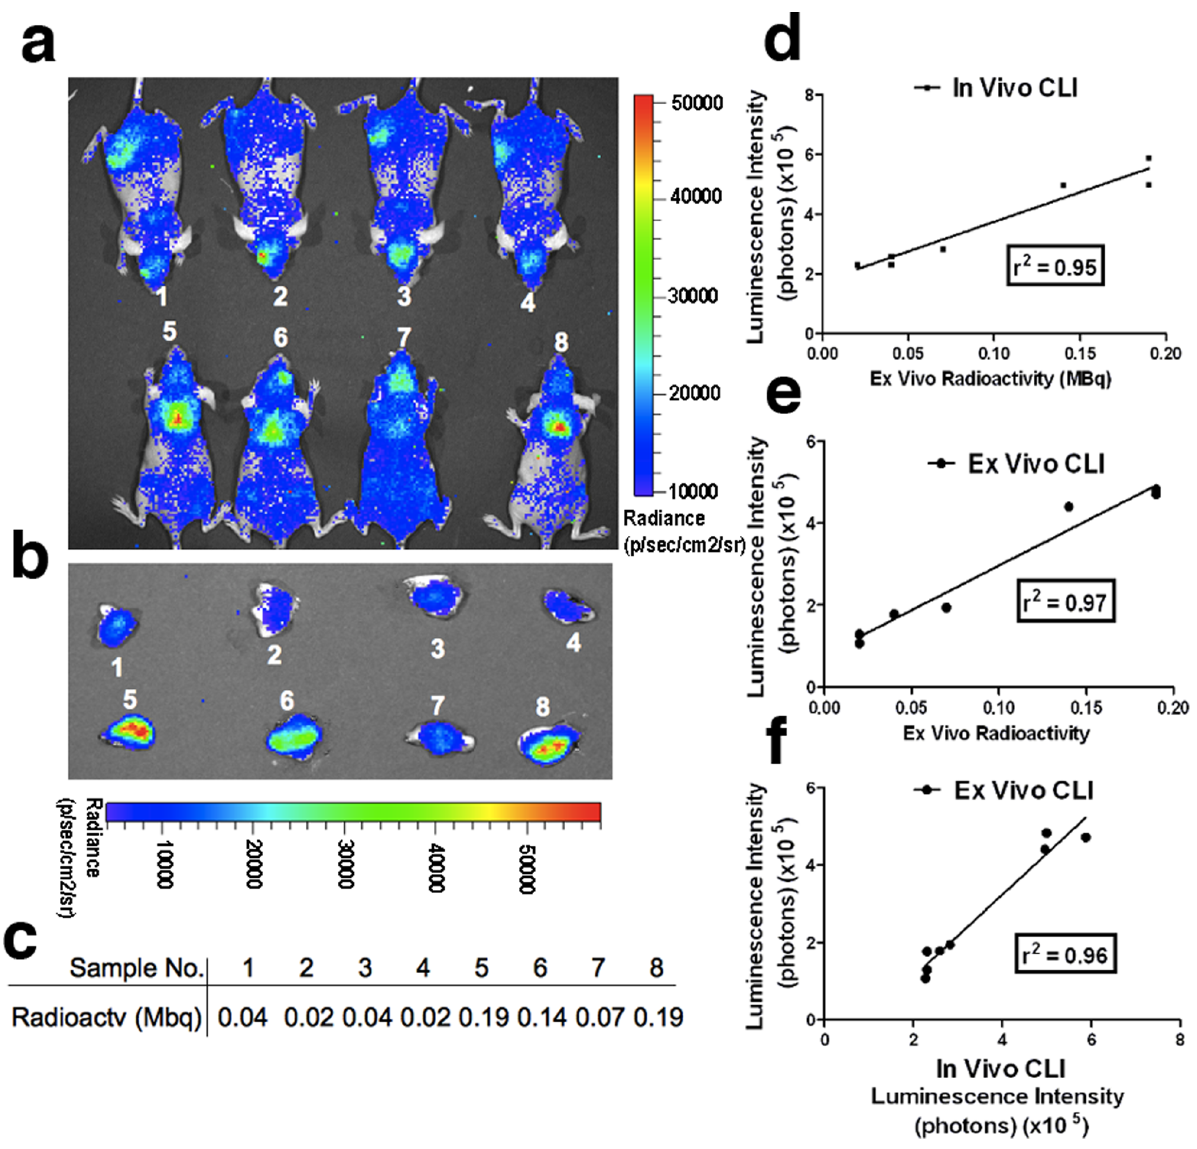
Figure 3. Reliability correlation studies of invivo CLI imaging, exvivo CLI imaging, and radioactive dosimetric countings of BAT. (a) In vivo CLI images of mice injected with 18 F-FDG under ketamine/xylazine anesthesia without (top panel, mice # 1–4) and with NE treatment (lower panel, mice # 5–8). (b) Ex vivo CLI images of BAT of mice in (a). (c) Dosimetric countings of ex vivo BAT in (b). (d) Correlation between in vivo CLI signals and dosimetric countings. (e) Correlation between ex vivo CLI signals and dosimetric countings. (f) Correlation between ex vivo CLI signals and in vivo CLI signals. Correlation plots in D-F suggest that in vivo CLI signals, ex vivo CLI signals, and ex vivo radioactivity measurements were highly